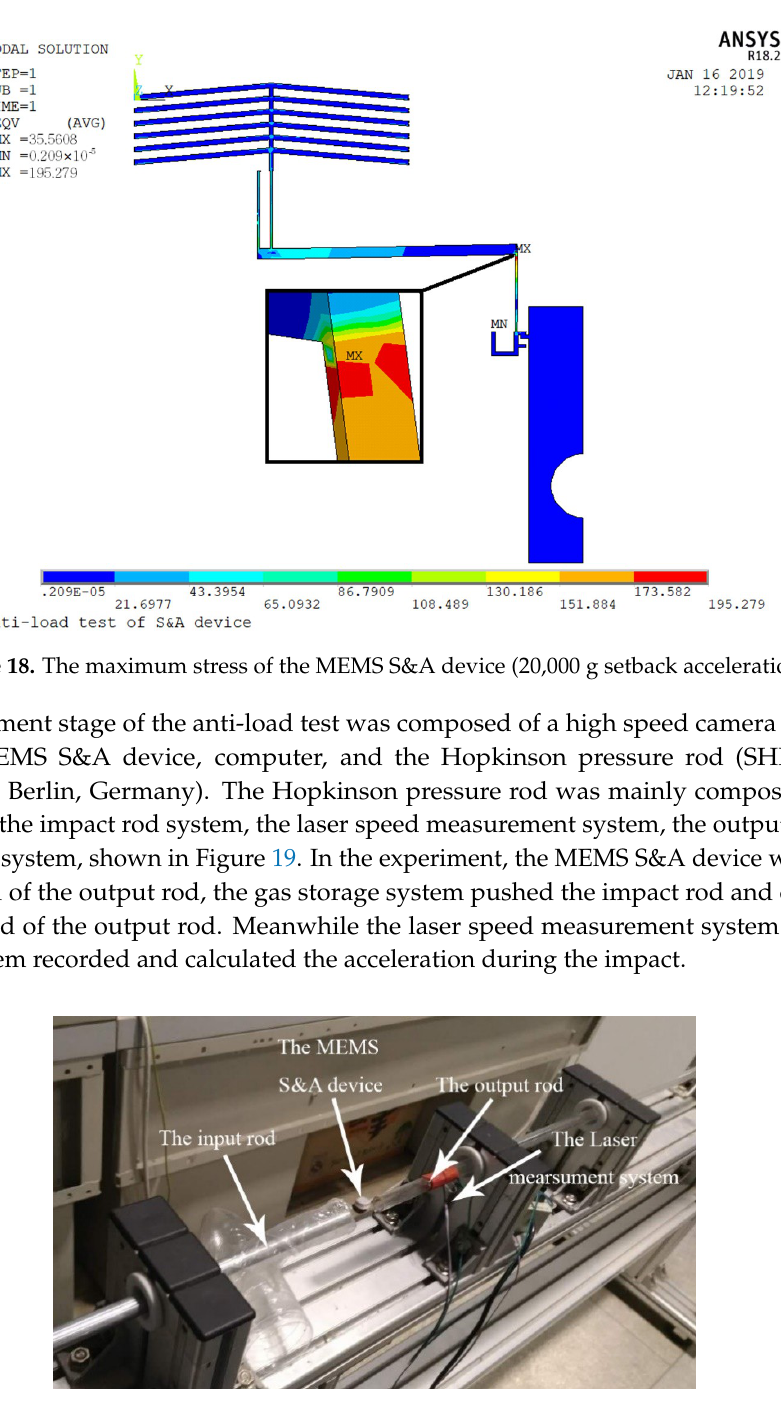
Figure 19. The Hopkinson pressure rod system.